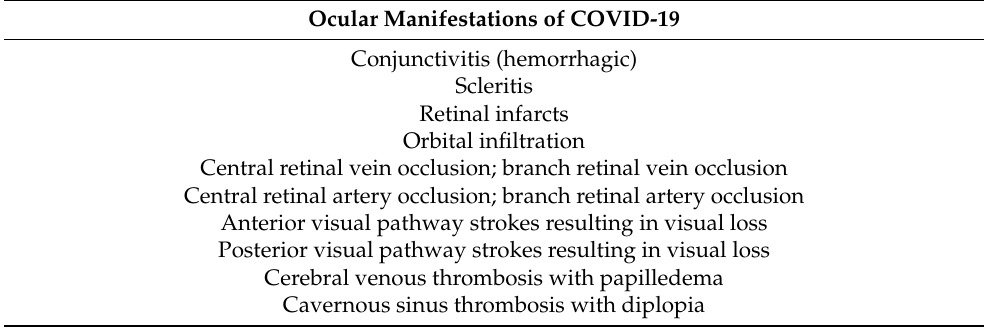
Table 8. Ophthalmic and neurologic manifestations of COVID-19 infection [88,89]. Ocular Manifestations of COVID-19 Conjunctivitis